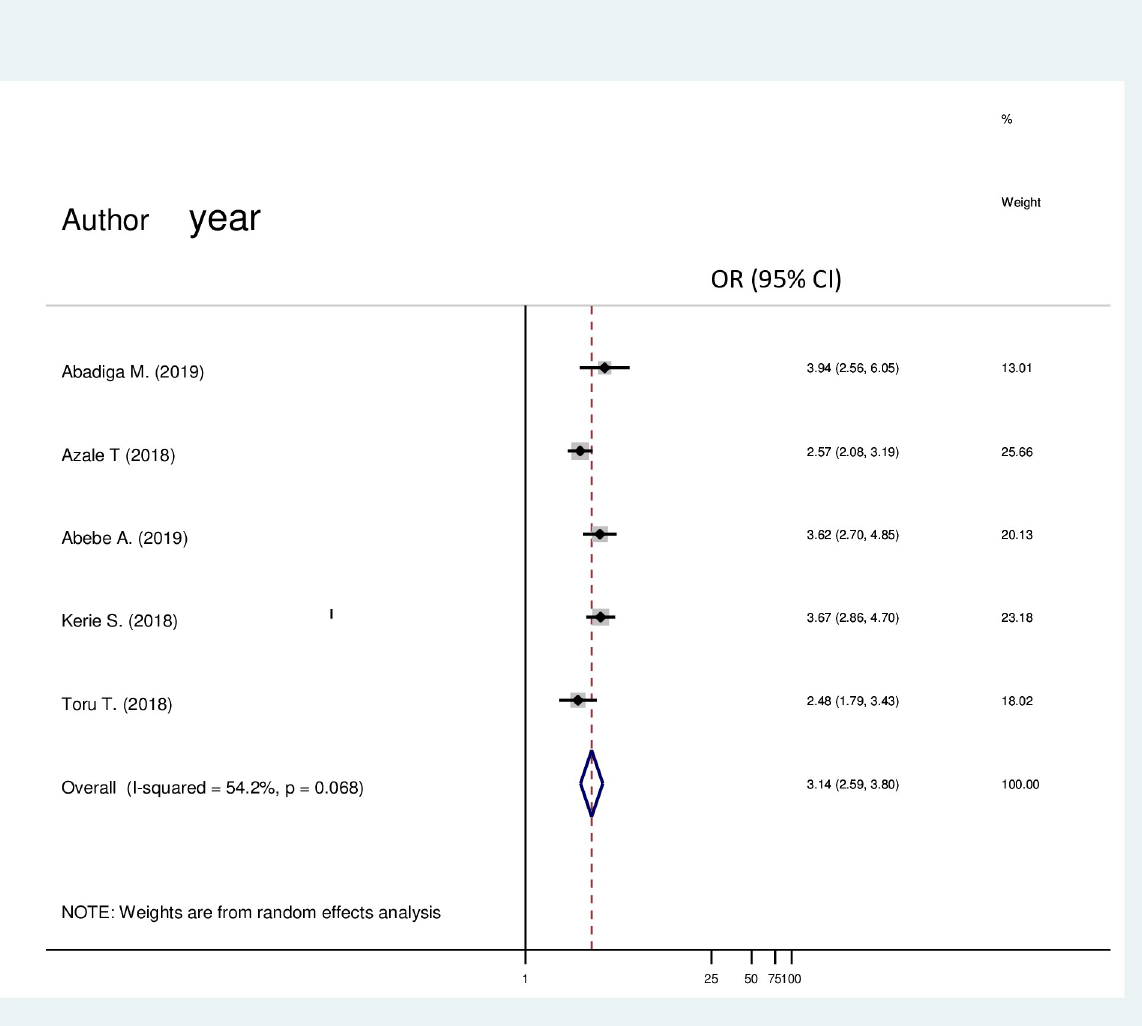
Fig 8. Forest plot pooled random effect size (OR) of domestic violence related to no domestic violence in post-partum depression among mothers in Ethiopia, 2020.